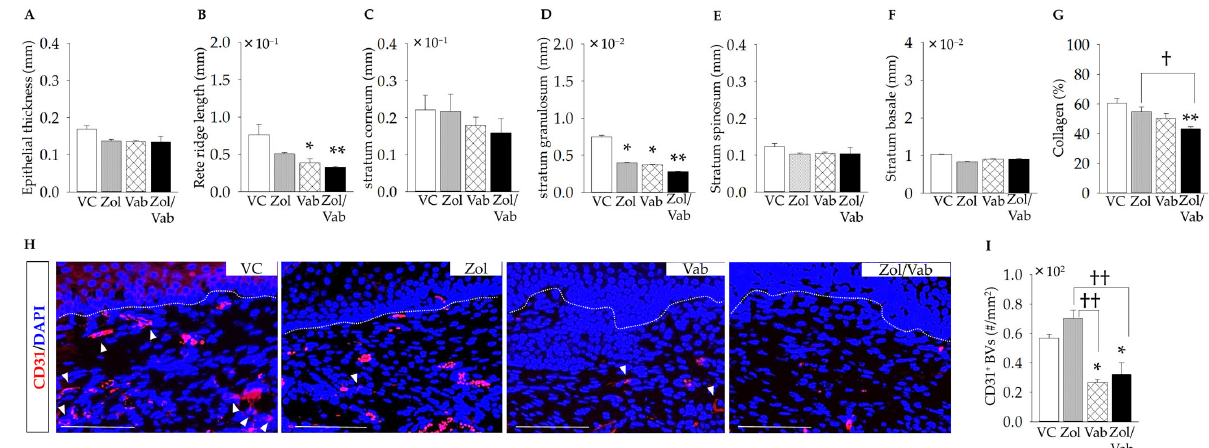
Figure 5. Effects of administered drugs on soft tissue wound healing of tooth extraction sockets. ( A ) No change is observed in epithelial thickness. ( B ) Rete ridge length is significantly decreased in Zol/Vab and Vab vs. VC. ( C ) Thickness of the stratum corneum is the same among the groups. ( D ) Thickness of the stratum granulosum is significantly decreased in Zol, Vab, and Zol/Vab vs. VC. ( E , F ) Thicknesses of the stratum spinosum and stratum basale are almost the same among the groups. ( G ) Collagen production is significantly decreased in Zol/Vab vs. VC and Zol. ( H ) Representative immunofluorescent images of CD31 + blood vessels (BVs) in the connective tissue of tooth extraction sockets (white arrowheads: CD31 + cells, bar: 100 μ m). ( I ) The number of CD31 + BVs is significantly decreased in Vab and Zol/Vab vs. VC and Zol. Graphs show means ± SEM. * p < 0.05, ** p < 0.01, † p < 0.05, †† p < 0.01; n = 5 mice/group.